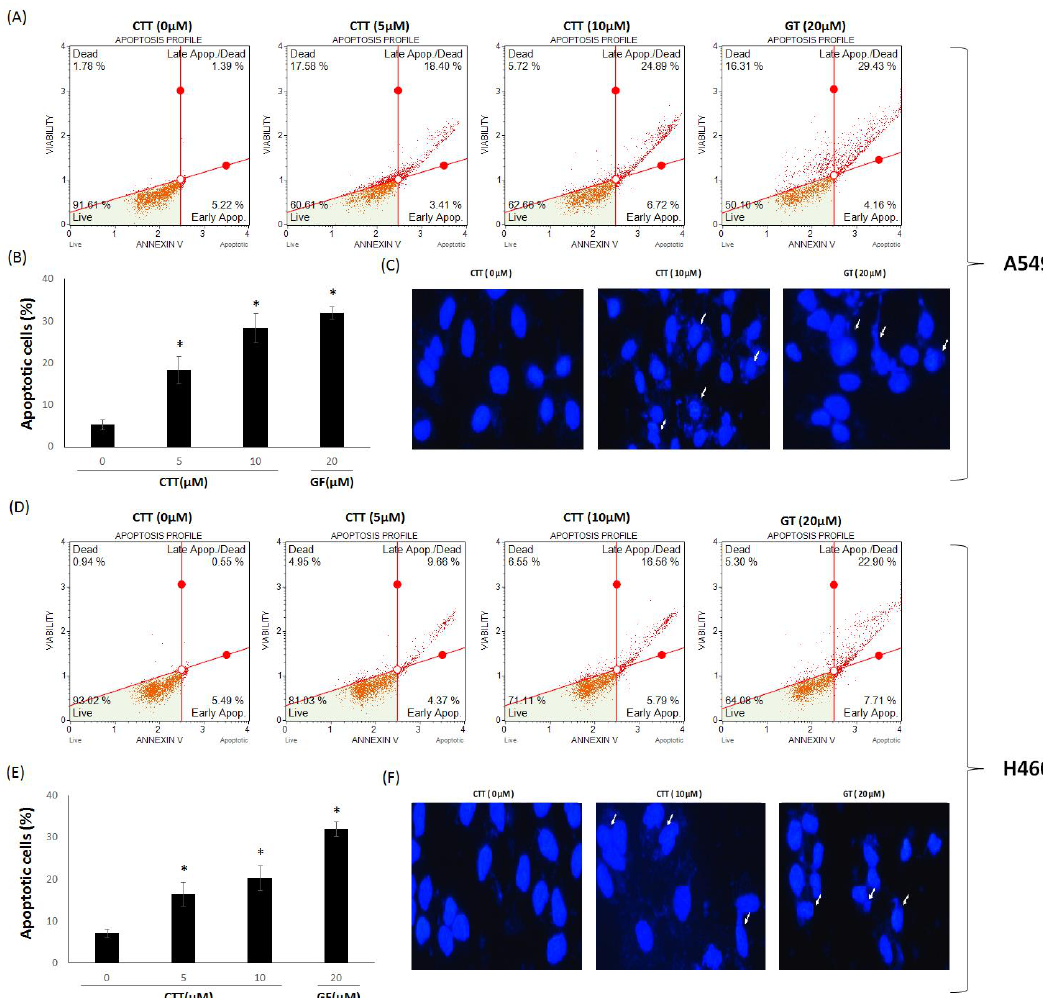
Figure 2. Effects of CTT treatment on apoptosis in A549 and H460 cells. ( A , D ) The cells were treated with 0, 5, or 10 µ M of CTT or 20 µ M GF (clinical anticancer drug) and stained with Annexin V, PI. After staining, flow cytometry was performed to determine apoptosis. ( B , E ) The histograms of the apoptotic cells were analyzed with a MUSE™ cell analyzer. ( C , F ) Nuclear condensation and fragmentation after 24 h of treatment with 10 µ M CTT or 20 µ M GF (clinical anticancer drug), stained with DAPI and visualized by fluorescent microscope (magnification, 400 × ). * p < 0.05 compared to the 0 µ M of CTT group. The data and images each represent one of the three independent experiments. Significant differences for the treated groups were determined by Duncan’s test for multiple comparisons. Values represented as mean ± SD from each experiment.